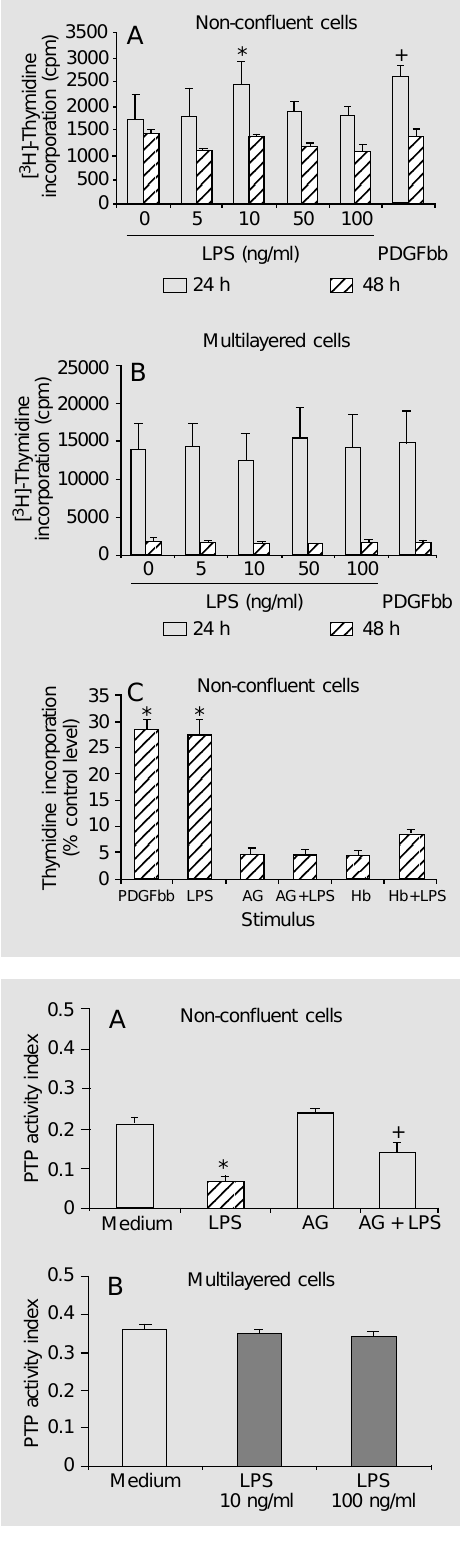
Figure 3. Effects of lipopolysaccharide (LPS)-induced NO production on protein tyrosine phosphatase (PTP) activities in rabbit vascular smooth muscle cells (RVSMC). RVSMC were incubated for 24 h with LPS. A , Non-confluent, low-density RVSMC were exposed to LPS (10 ng/ml). The inducible NO synthase inhibitor aminoguanidine (AG, 400 µM) was added 30 min prior to the incubation with the endotoxin, as indicated. B , Concentration-dependent effects of LPS on RVSMC- associated PTP activities in multilayered cultures. After 24 h, cells were lysed and lysates had their protein concentration determined. Protein contents were matched (100 µg) and PTP activity in lysates was meas- ured as described in Material and Methods. Results are reported as means ± SD of three independent experi- ments. *P<0.01 compared to medium and + P<0.05 compared to cells pretreated with AG (Student t